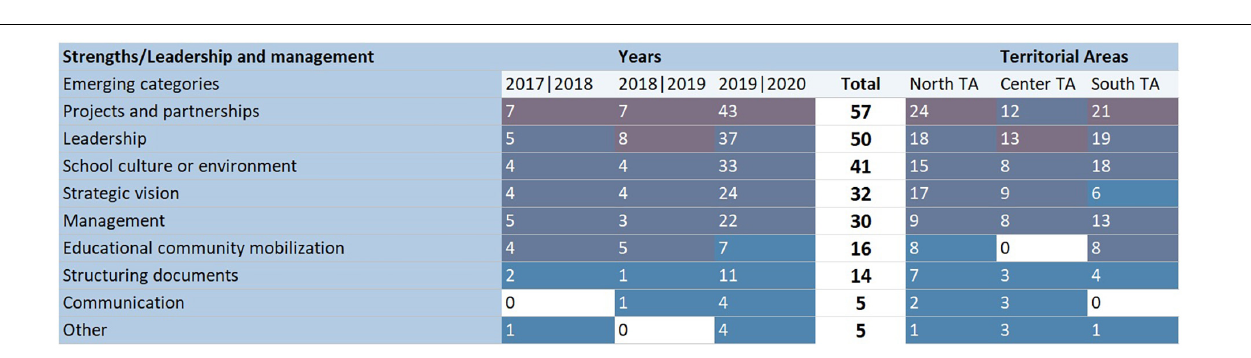
FIGURE 5 | Leadership and management: strengths. The distribution of coded segments by subcategories, year, and